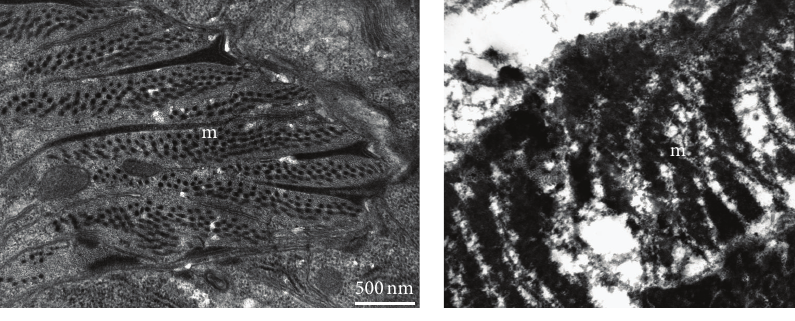
(b) Changes in the muscle cell (m) with extract treat- ment, compared with control